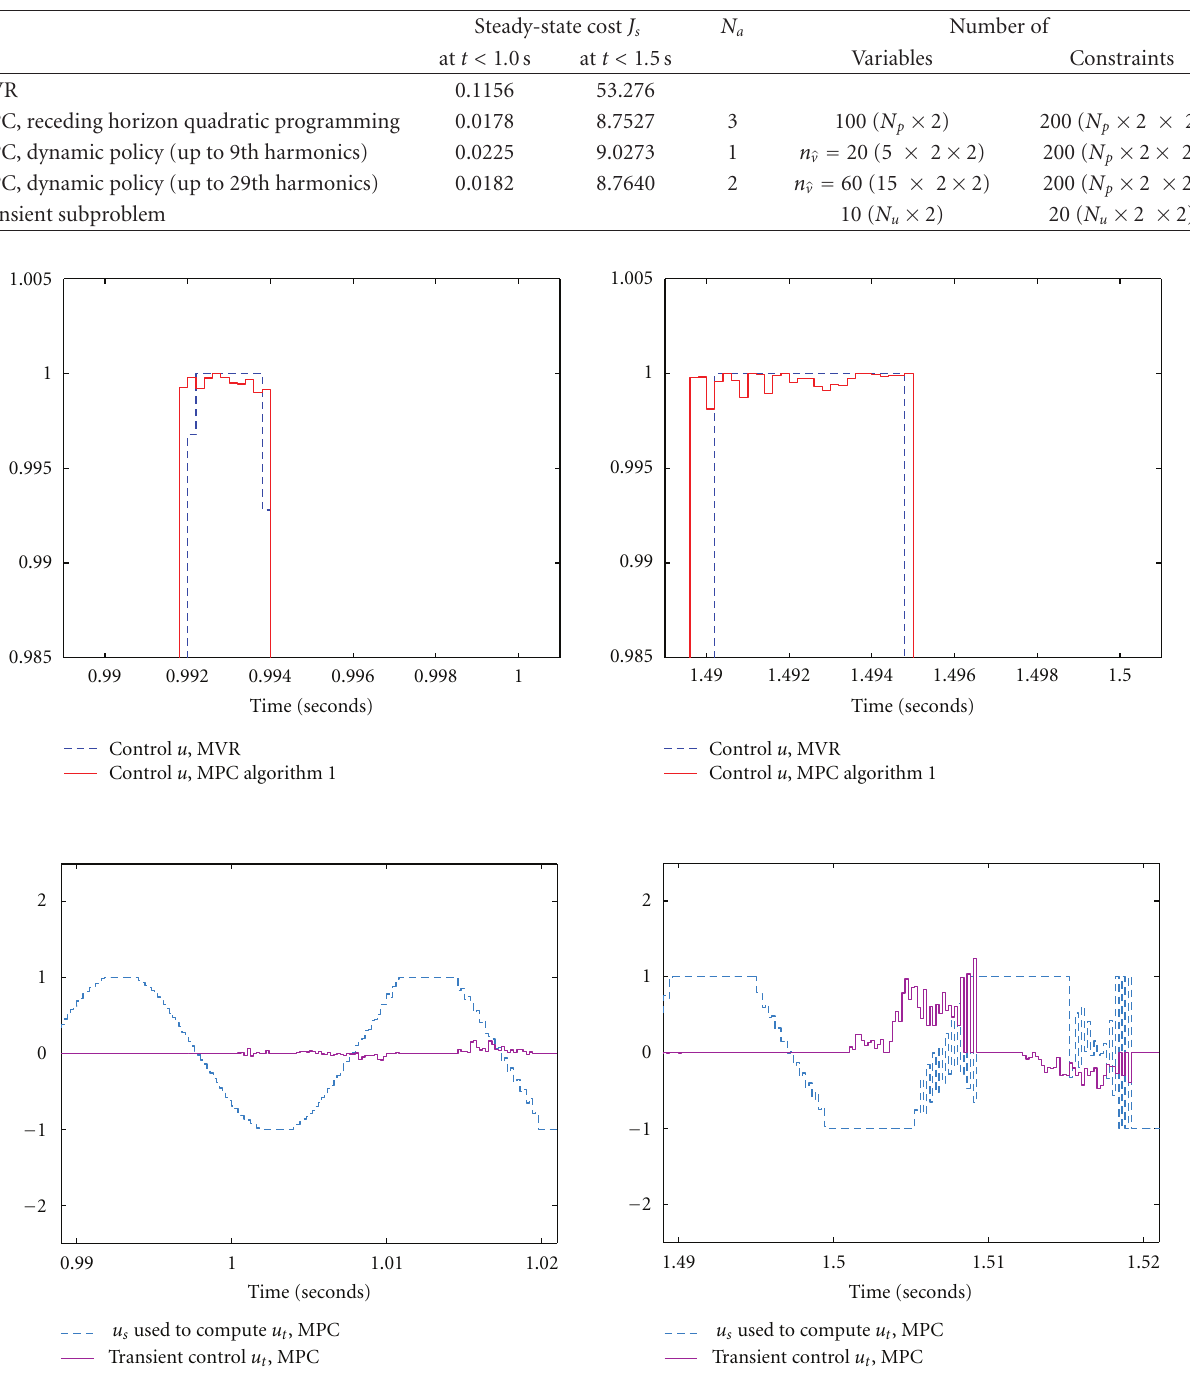
Figure 4: The first component of controls u and u t before and after transitions at t = 1 . 0s and t = 1 .